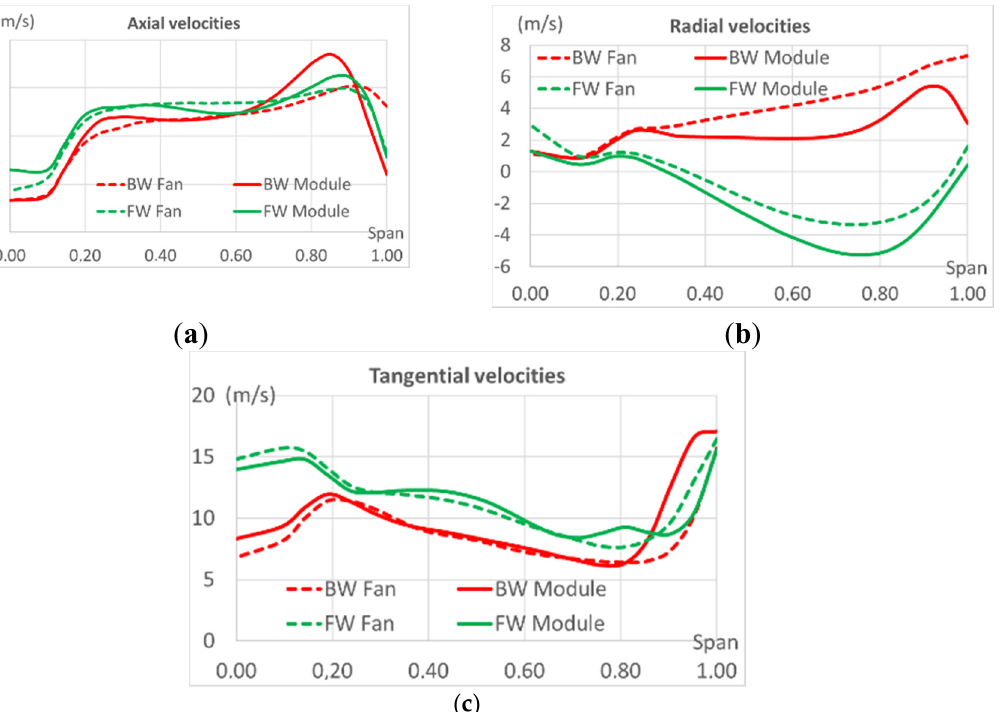
Figure 11. Velocity components for the di ff erent configurations: ( a ) axial velocity, ( b ) tangential velocity, and ( c ) radial velocity .